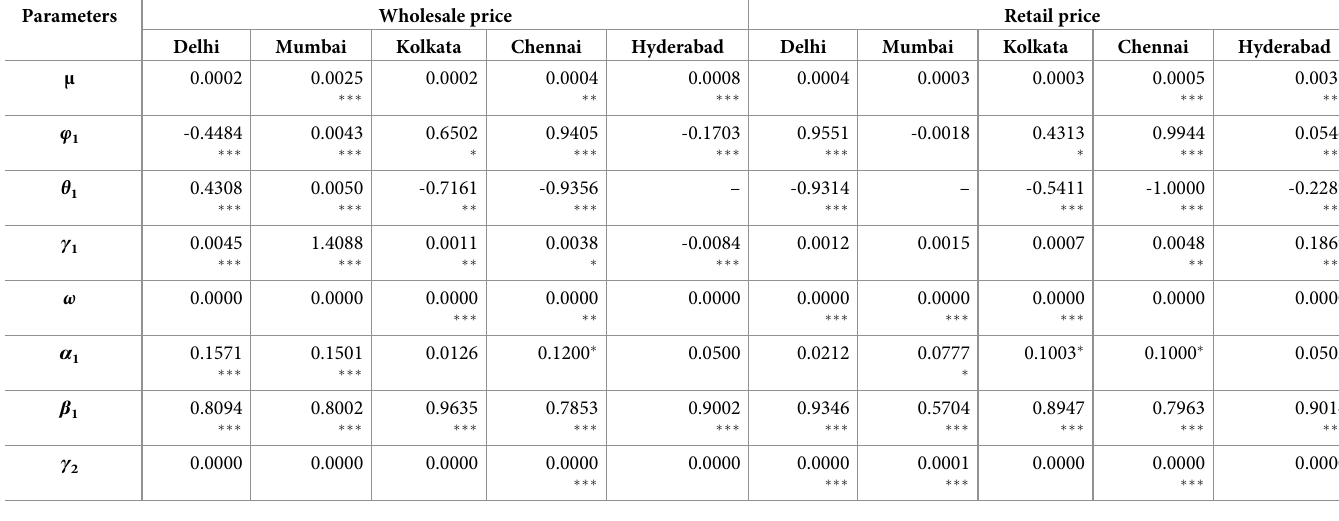
Table 3. Parameters estimate of GARCH-X model for